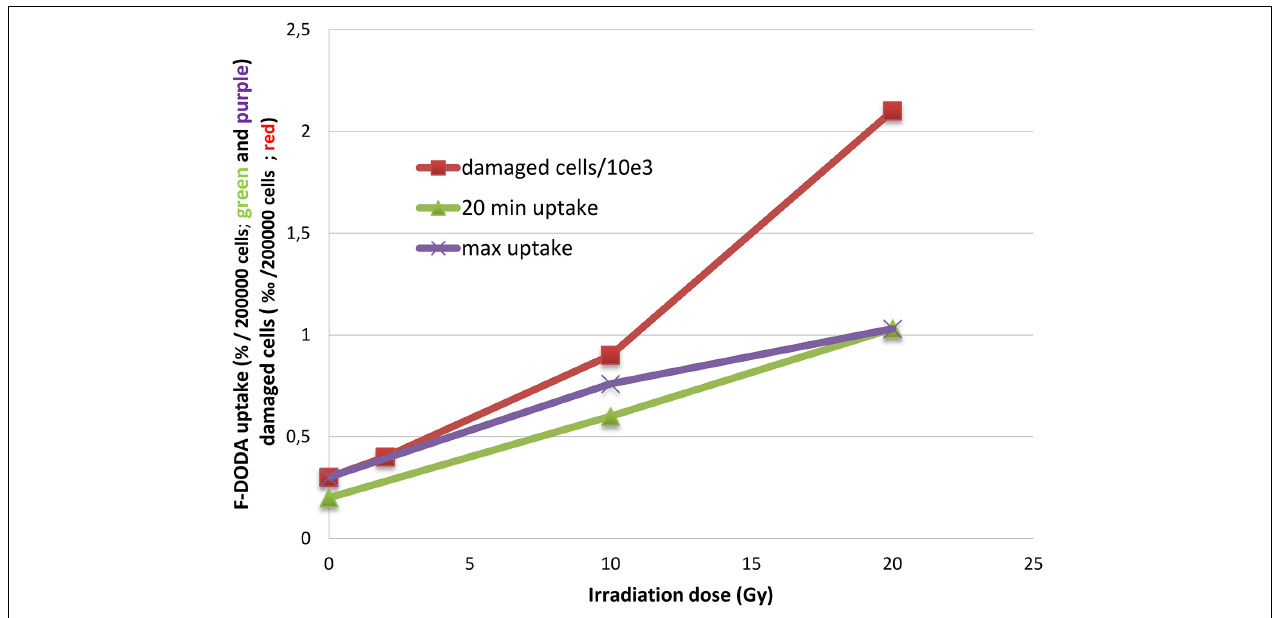
FIGURE 4 | Trend of 18 F-DOPA uptake after 20 min and at the peak activity compared to the number of damaged